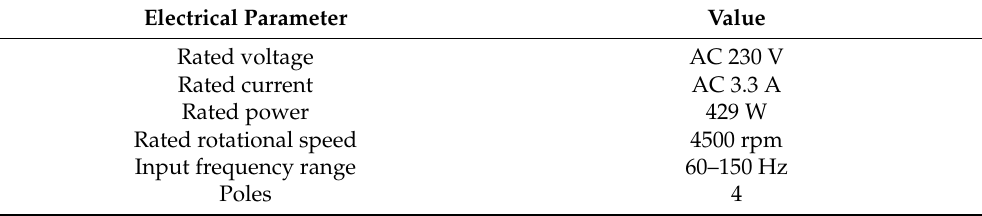
Table 4. Inverter